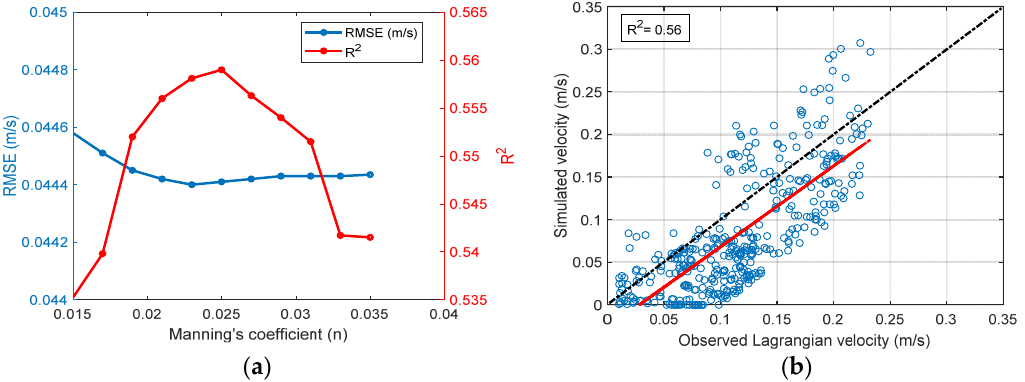
Figure 12. Lagrangian calibration: ( a ) RMSE and R 2 variations against Manning’s coe ffi cient iterations, ( b ) relationship between observed Lagrangian drifters and simulated